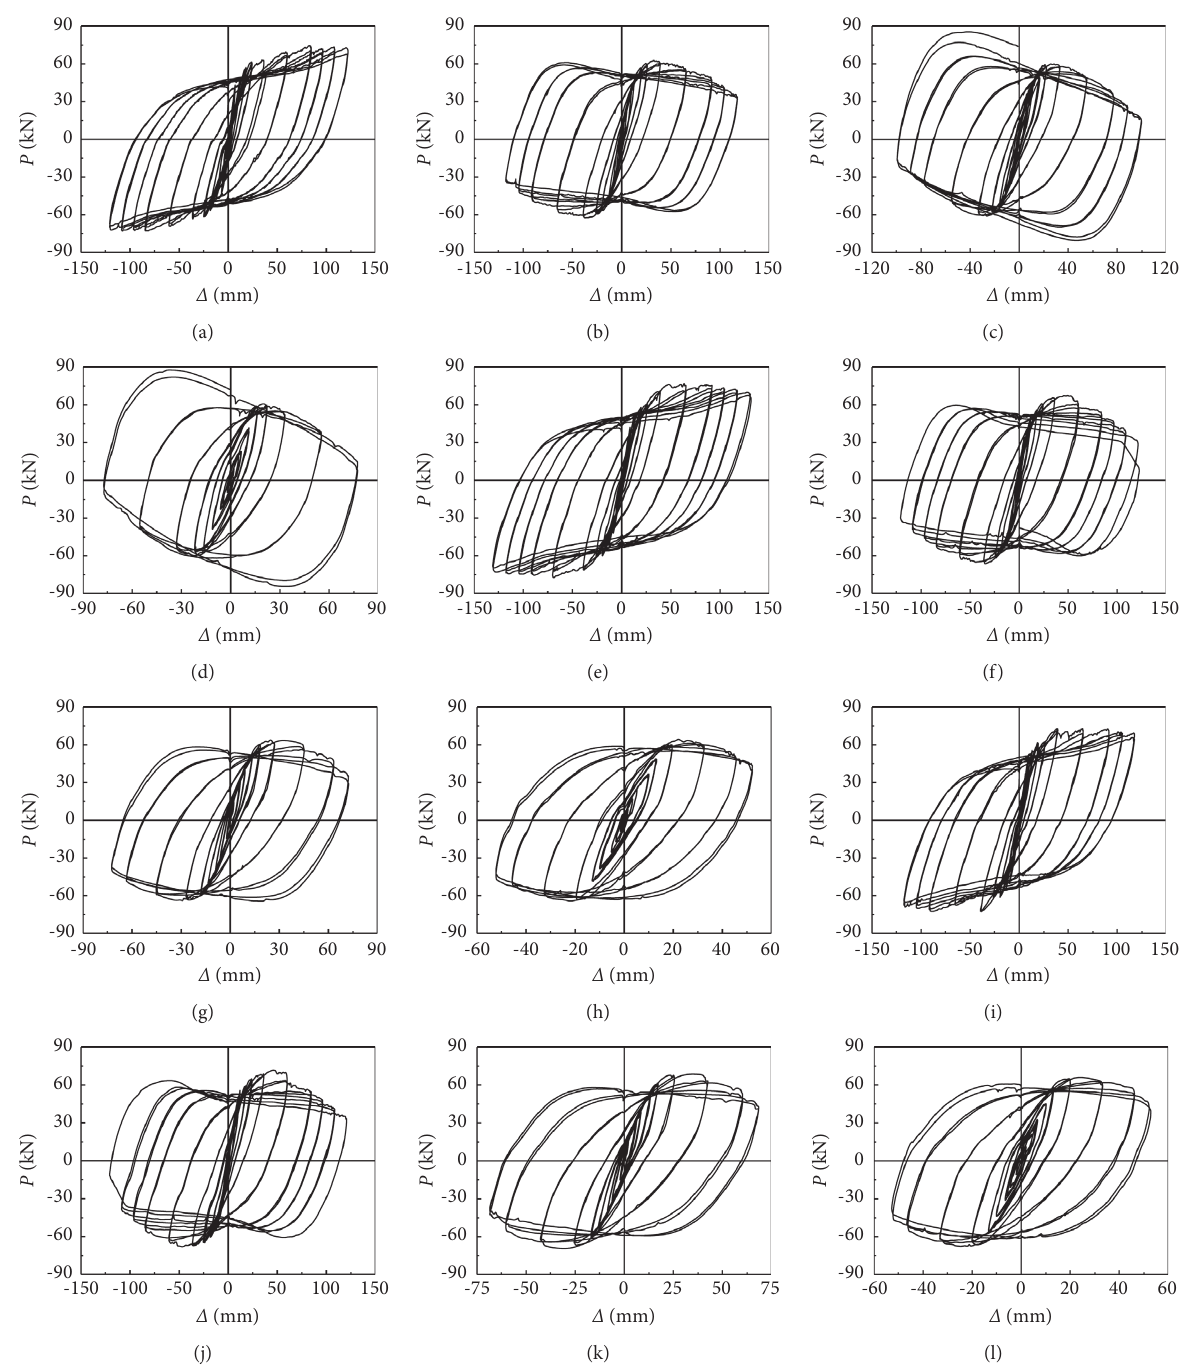
Figure 9: P - Δ curves of specimens. (a) A0 specimen. (b) B0 specimen. (c) C0 specimen. (d) D0 specimen. (e) A1 specimen. (f) B1 specimen. (g) C1 specimen. (h) D1 specimen. (i) A2 specimen. (j) B2 specimen. (k) C2 specimen. (l) D2